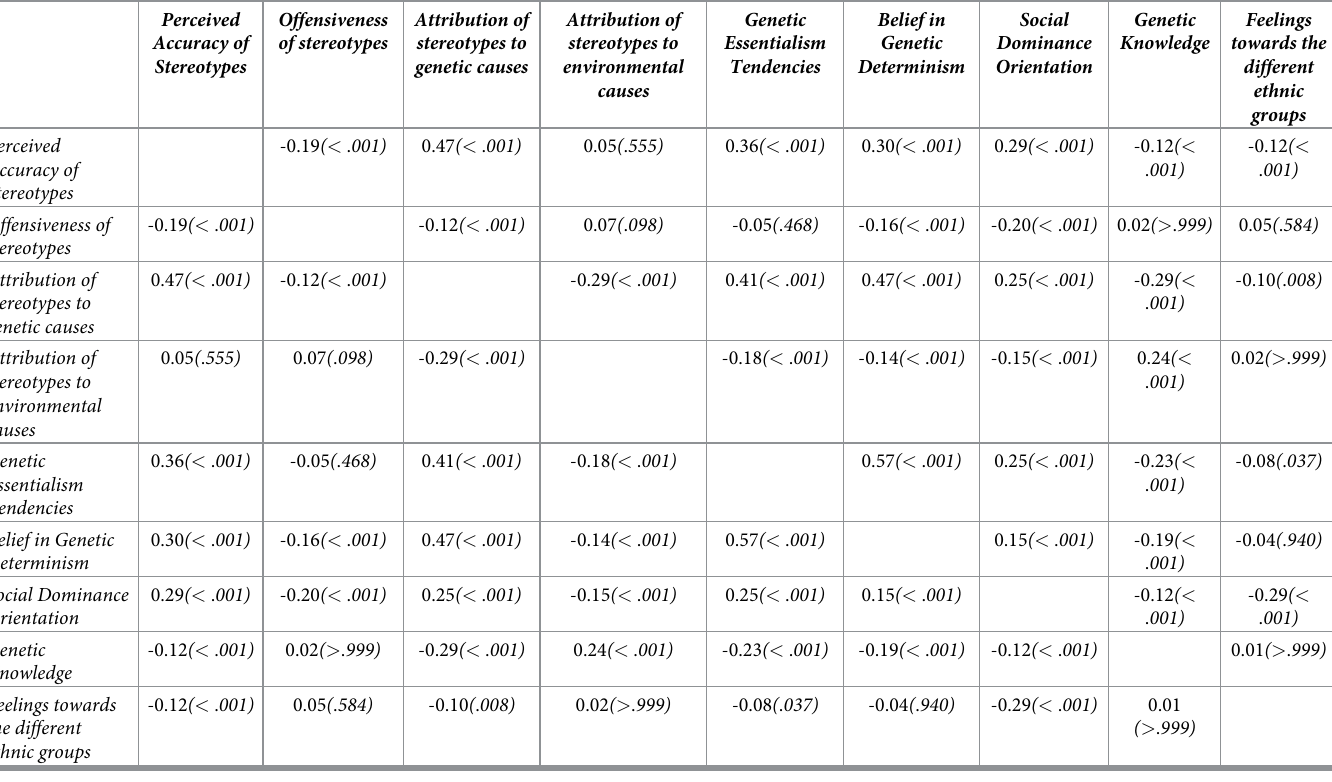
Table 2. Correlations between perceived accuracy of stereotypes, offensiveness of stereotypes, attribution of stereotypes to genes, attribution of stereotypes to envi- ronment, genetic essentialism tendencies, belief in genetic determinism, social dominance orientation, knowledge, and feelings towards ethnic groups. Perceived Accuracy of